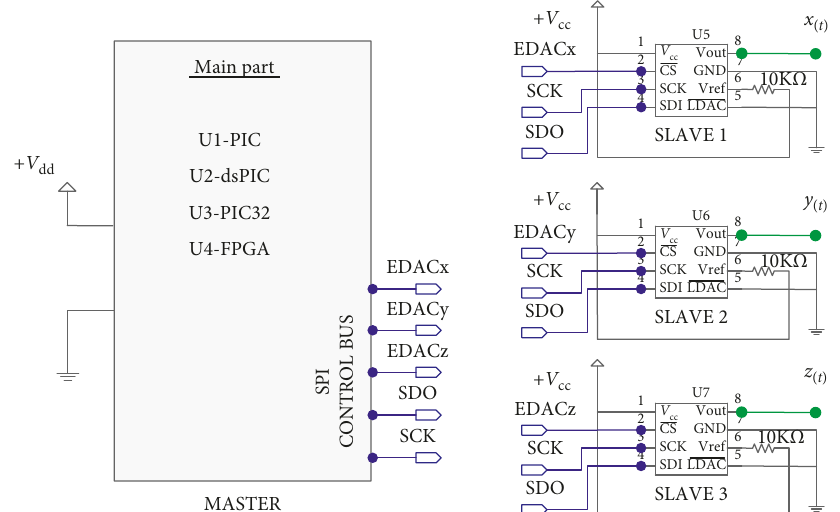
Figure 5: Schematic circuit of ES for V1–V4.